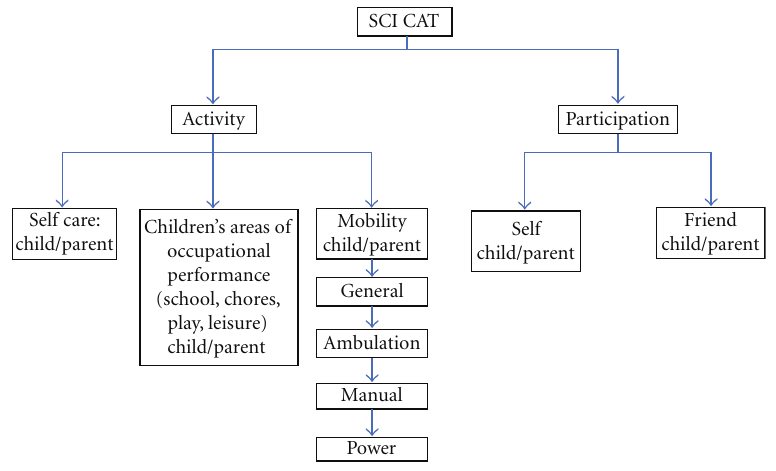
Figure 2: SCI CAT constructs, domains, and subdomains. Table 3: Total number of items and examples for each construct, domain and